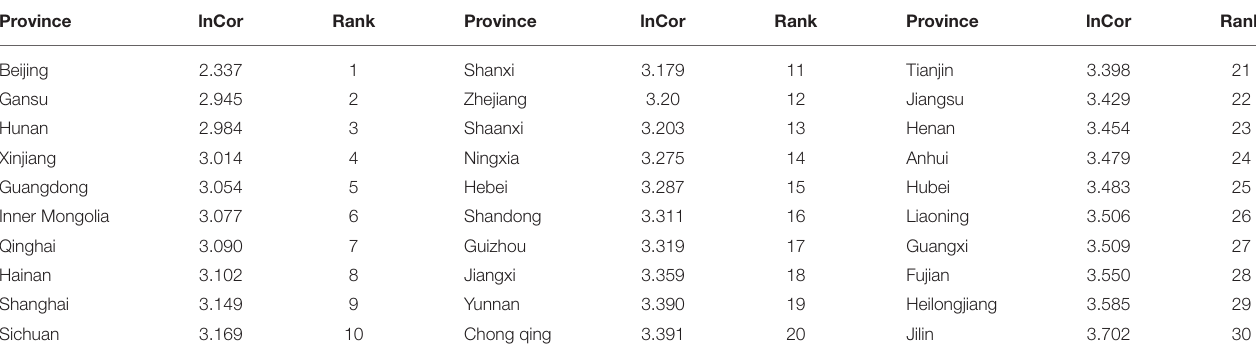
TABLE 4 | Ranking of corruption of 30 provinces of China and provincial municipalities 2000–2017. Province lnCor Rank Province